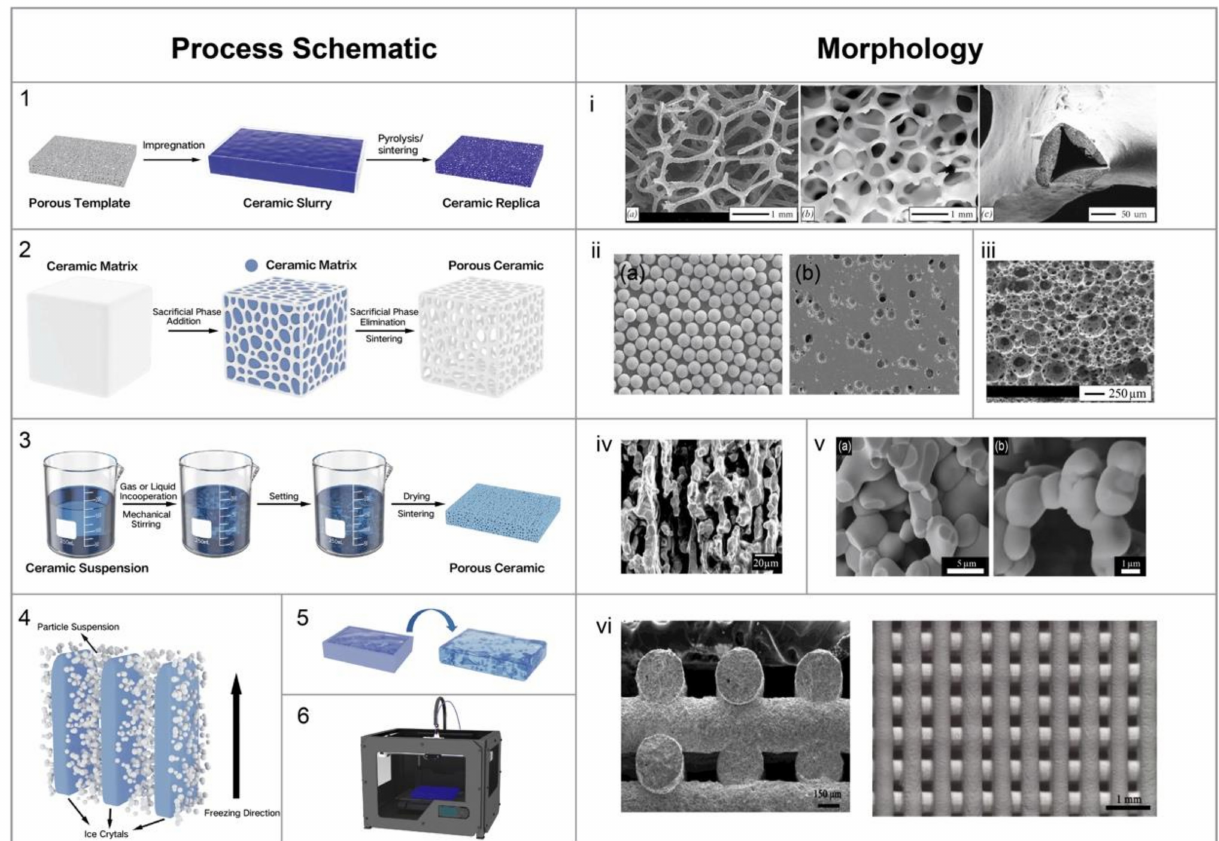
Figure 2. Schematic of processes and their corresponding morphologies: ( 1 , i ) replica template [20], Reproduced with permission, Copyright 2006, Phil. Trans. R. Soc. A.; ( 2 , ii ) BURPS [21], Reproduced with permission, Copyright 2007, J. Eur. Ceram. Soc.; ( 3 , iii ) Direct Foaming [22], Reproduced